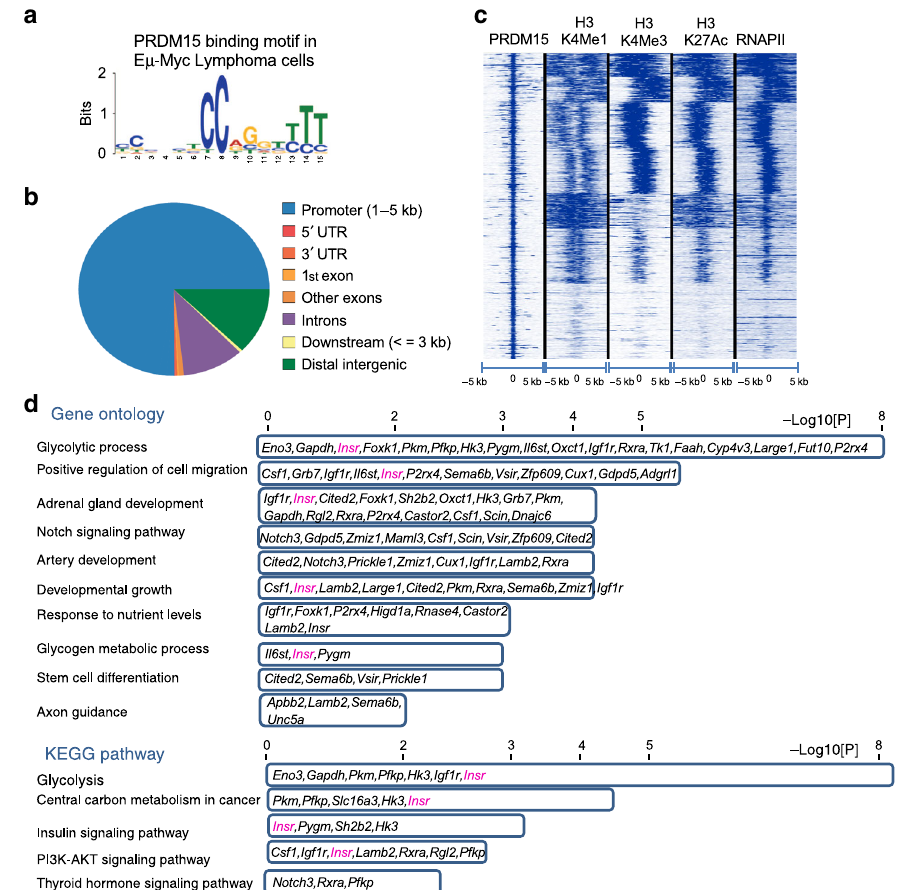
Fig. 4 PRDM15 promotes the transcription of key regulators of cancer metabolism. a De novo motif discovery. Motif bound by PRDM15 in vivo in E µ -Myc B-cell lymphomas. b Distribution of PRDM15 peaks in relation to genes. c Density plot of H3K4Me1, H3K4Me3, H3K27Ac, and RNAPII occupancy relative to PRDM15-binding sites in E µ -Myc B-cell lymphomas. d Enriched pathways in genes directly bound by PRDM15 and deregulated in Prdm15 Δ / Δ cells ; Insr was present in most of the KEGG and GO